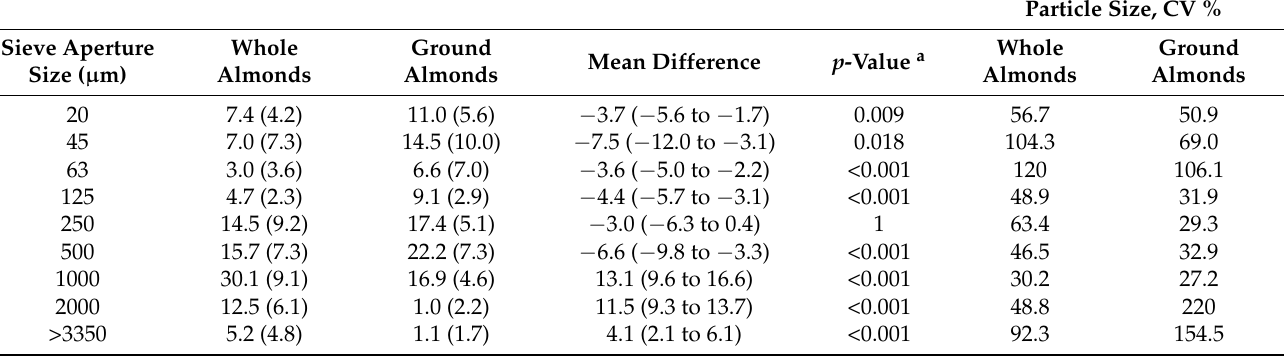
Table 3. Particle size distributions of masticated whole and ground almonds assessed by the mechan- ical sieving